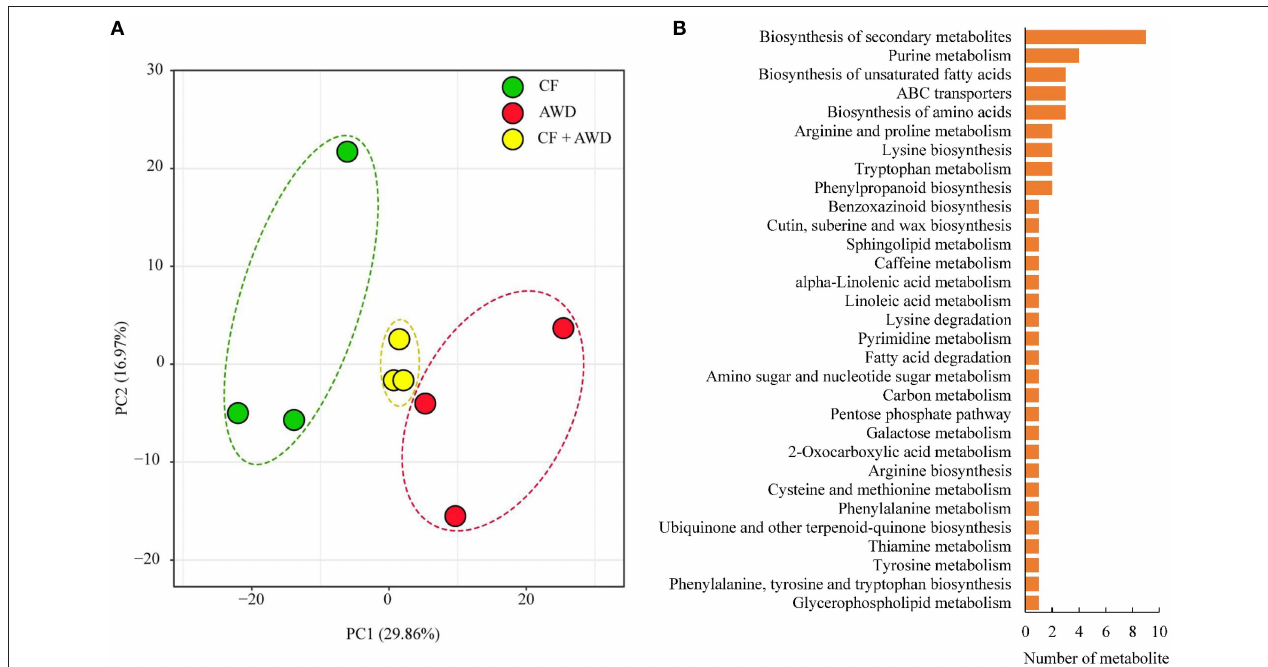
FIGURE 2 | Exploratory analysis of metabolite accumulation in AWD vs. CF. (A) PCA analysis of metabolites identified in CF, AWD samples. Equal volumes of CF and AWD milled rice samples were mixed for use as a quality control (QC) sample. (B) Kyoto encyclopedia of genes and genomes classification of differentially accumulated metabolites.